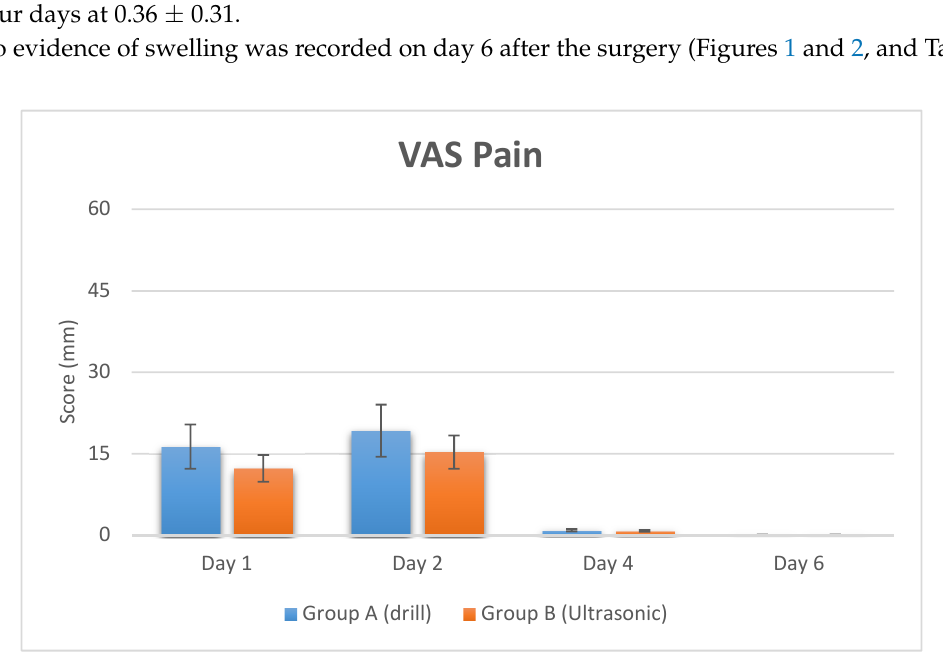
Figure 1. Pain rate of patients in post-operative times recorded by VAS Score.